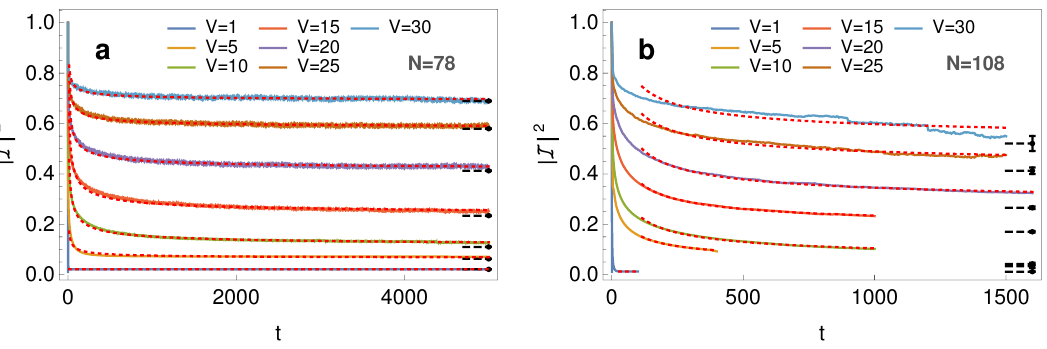
Figure 9: Modulus-squared imbalance | I | 2 as a function of time for the two clusters N = 78 (left) and N = 108 (right). The red dotted lines are 1 / time dynamics. The rightmost dashed lines and corresponding error bars are the extrapolated asymptotic values, also shown in Fig.